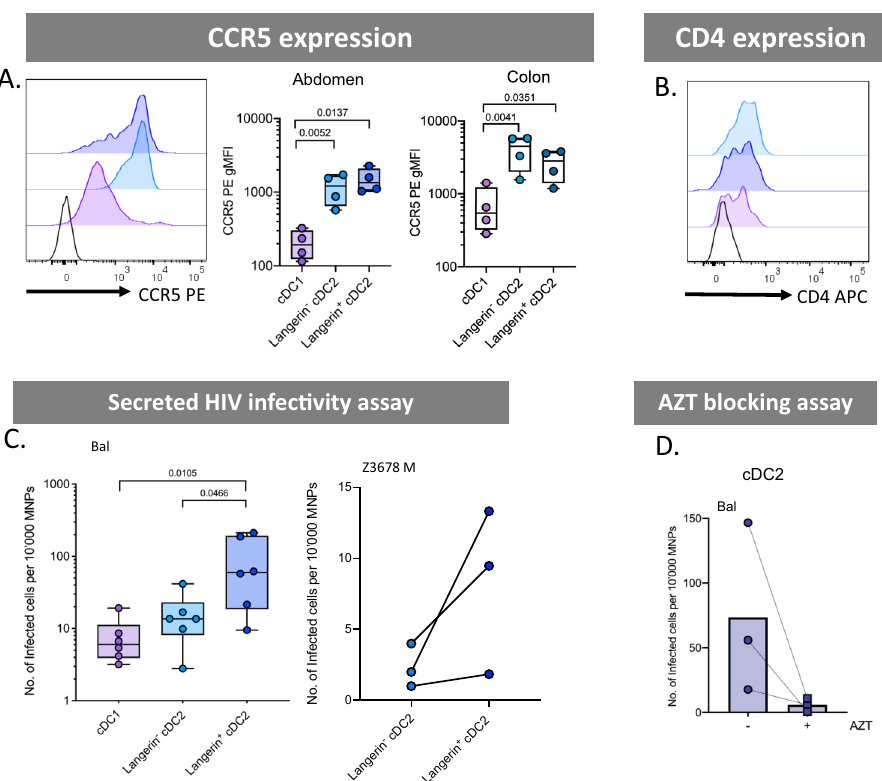
Fig. 9 HIV infectivity and 2nd phase transfer capacity of dermal dendritic cells. A HIV co-receptor CCR5 expression was analysed by fl ow cytometry. Left: representative histogram of one donor, black un fi lled histogram represents FMO control. CCR5 gMFI minus the FMO for abdominal skin (middle n = 4) and colon (right n = 4) plotted as box and whisker plots, box representing the upper and lower quartile, central line representing the median, the whiskers the minimum and maximum of each cell subset and each donor represented by an individual dot. Statistics were generated using a RM one-way ANOVA with Holm – Sidak ’ s multiple comparisons with adjusted P values shown. B HIV receptor CD4 expression levels on one abdominal skin donor with isotype control represented by black, un fi lled histogram. C Cell supernatants from FACS isolated dermal DCs infected with HIV were taken for TZMBL infectivity assays and the number of infected TZMBL cells per 10 4 MNPs were calculated. Left: HIV Bal infectivity plotted as box and whisker plots as in A , n = 7. Statistics were generated using a RM one-way ANOVA with Holms – Sidak ’ s multiple comparisons with adjusted P values shown. Right: HIV Z3678M infectivity assay with each dot representing individual donors matched by connecting lines ( n = 3). Due to low cell numbers cDC1 data could not be obtained. D Combined sorted cDC2 were pre-treated with or without azidothymidine (AZT) before 2-h HIV Bal infection. AZT was washed off after 48h and cell supernatants collected after a further 48h. Secreted HIV was assessed using a TZMBL infection assay. Each donor represented by individual point matched with joining lines, circles represent untreated cells and squares represent AZT treated cells, column representing the mean. cDC1 (purple), langerin − cDC2 (light blue) and langerin + cDC2 (dark